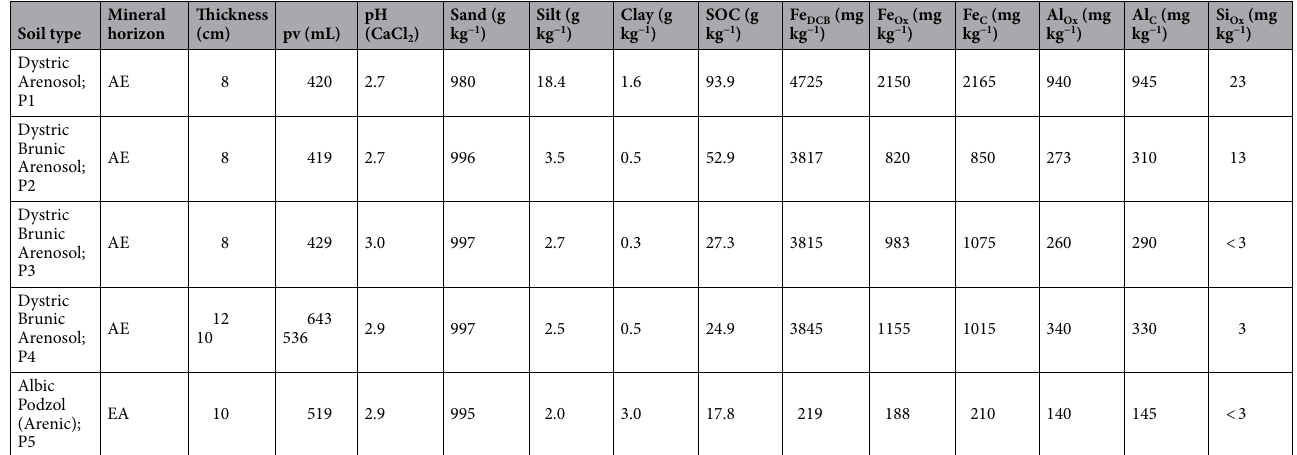
Table 1. Selected properties of soils 22 used in irrigation experiments (pv, pore volume; SOC, soil organic carbon). The subscripts index element extraction by dithionite-citrate-bicarbonate (DCB), oxalate (Ox), and citrate (C). Two pore volumes are given for Sample P4 because of varying thickness of the mineral horizon between the two